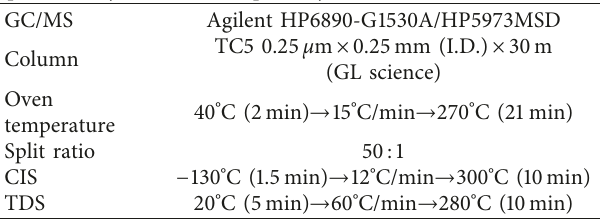
Figure 2: Schematic of the thermal desorption test chamber system.